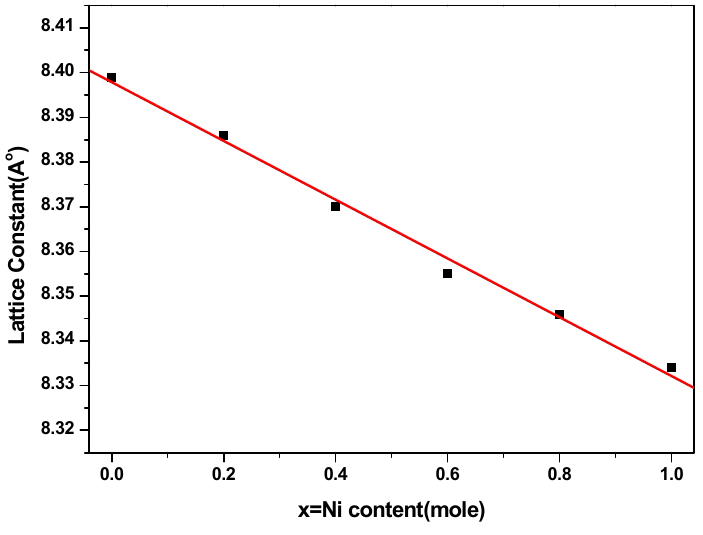
Fig. 2 Lattice parameters of Ni x Co 1 − x Fe 2 O 4 (x=0, 0.2, 0.4, 0.6, 0.8,